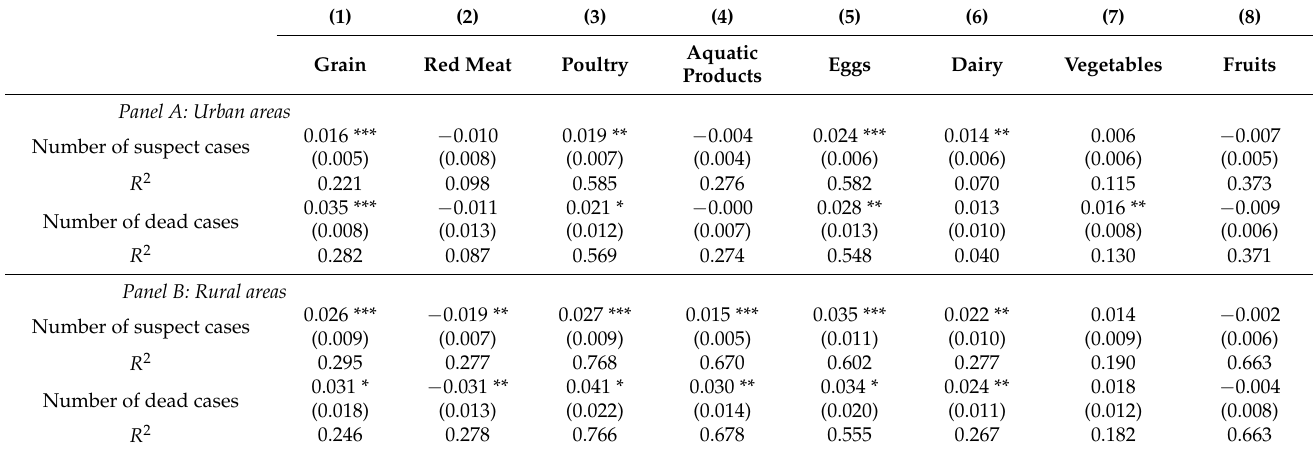
Table 7. Robustness checks: different measures of